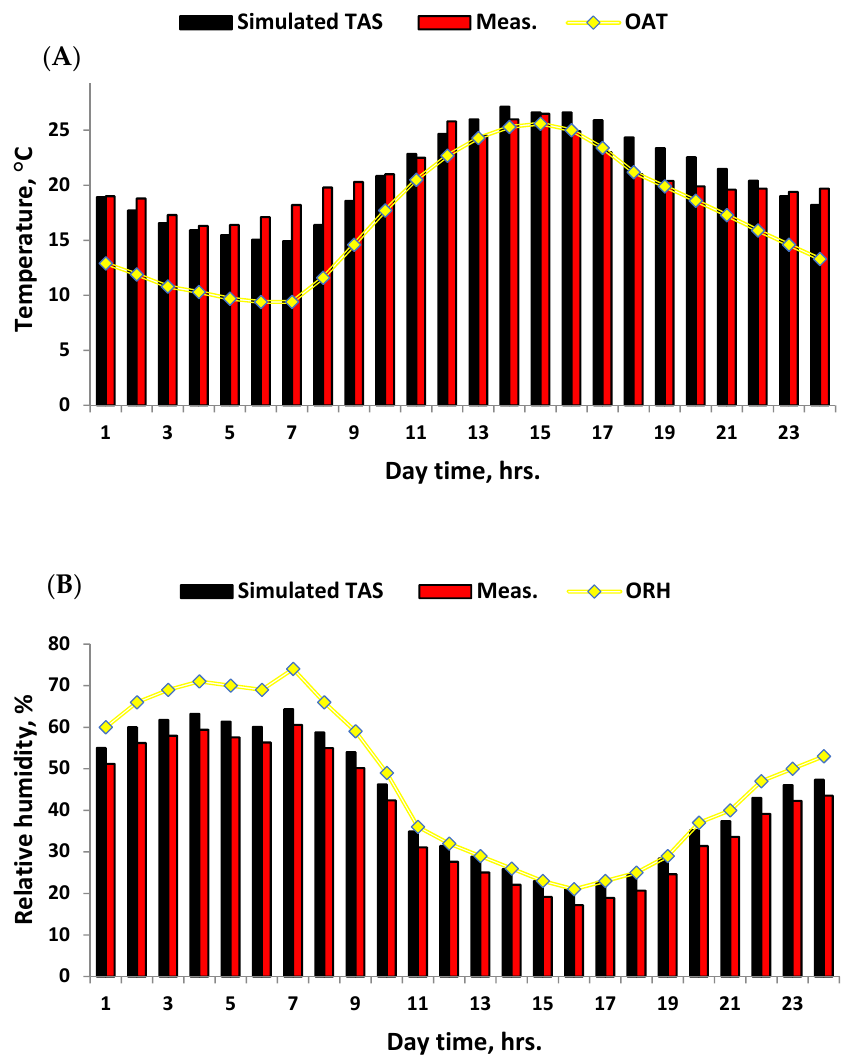
Figure 5. Calibration of the indoor temperatures ( A ) and relative humidity ( B ) where Meas. is measured data, OAT is outdoor air temperature and ORH is outdoor relative humidity .